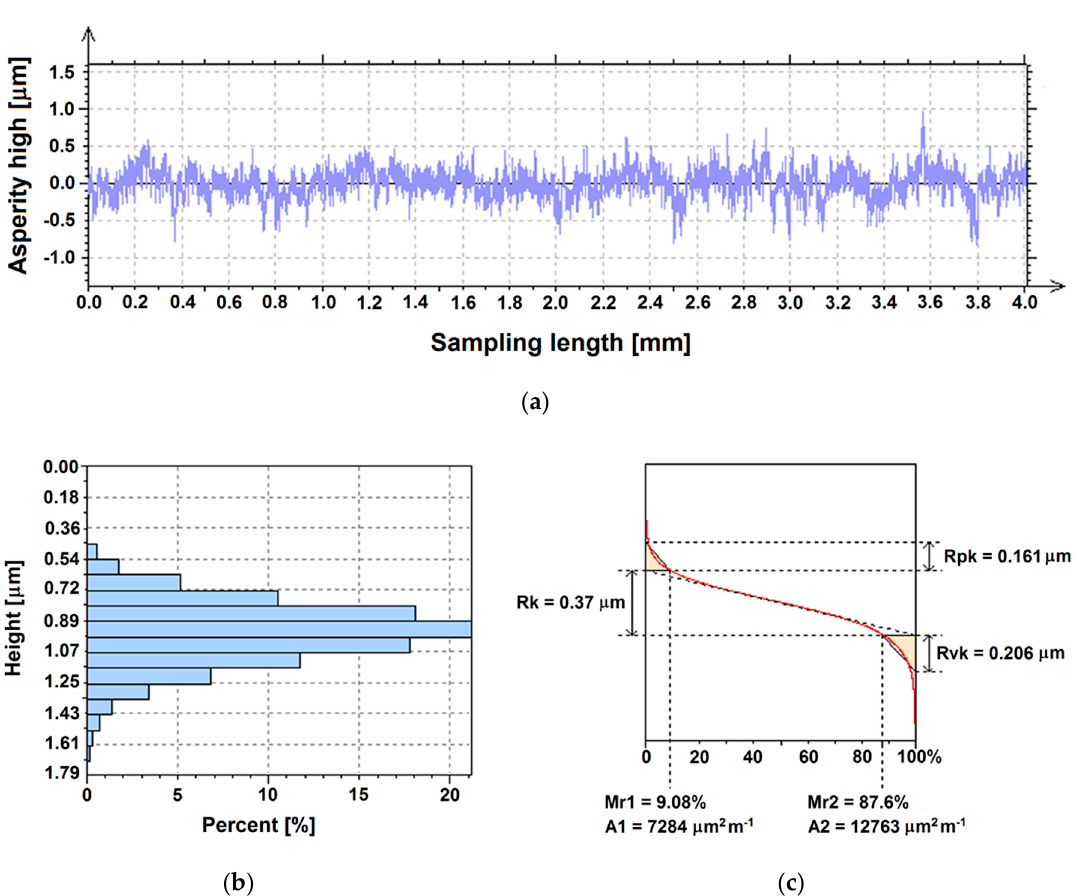
Figure 4. Sample profile recorded for the Ti G4 with machine surface: ( a ) Roughness profile; ( b ) Distribution of the height ordinate; ( c ) Surface bearing area ratio curve.